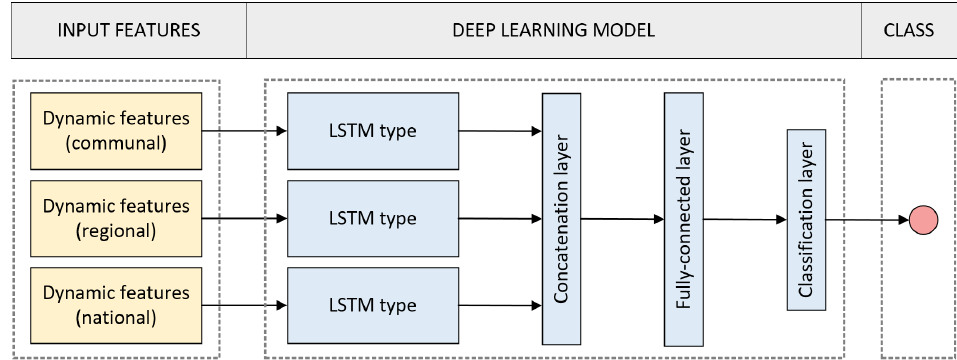
Figure 3. Proposed deep learning model to estimate the risk of COVID-19